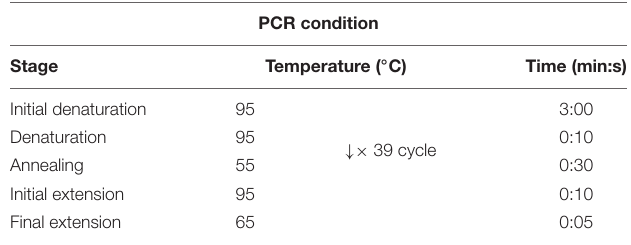
TABLE 1 | Condition of real-time